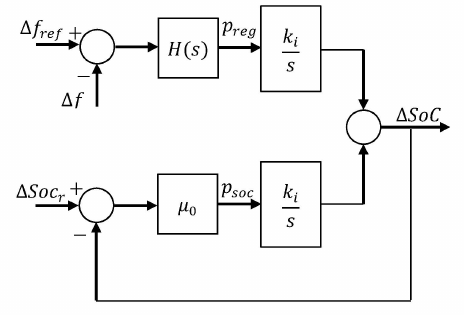
Figure 4. Block diagram of the battery control